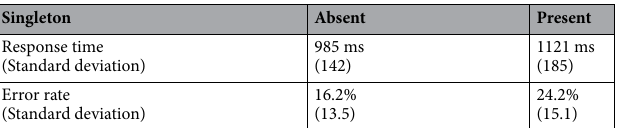
Table 1. Mean and standard deviation of response times and error rates (across the 15 participants) depending on the presence of the bright singleton.